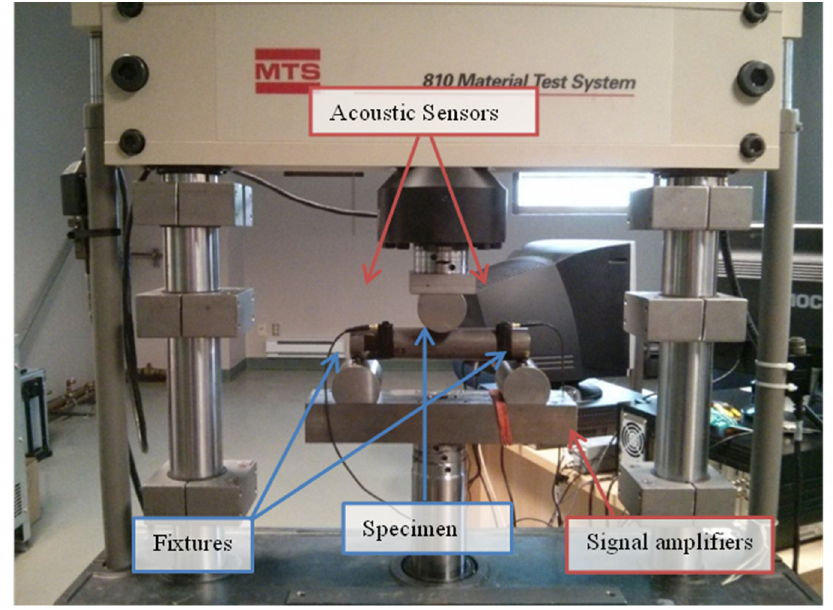
Figure 11. Setup for cyclic bending at constant load test on cylindrical foam-filled